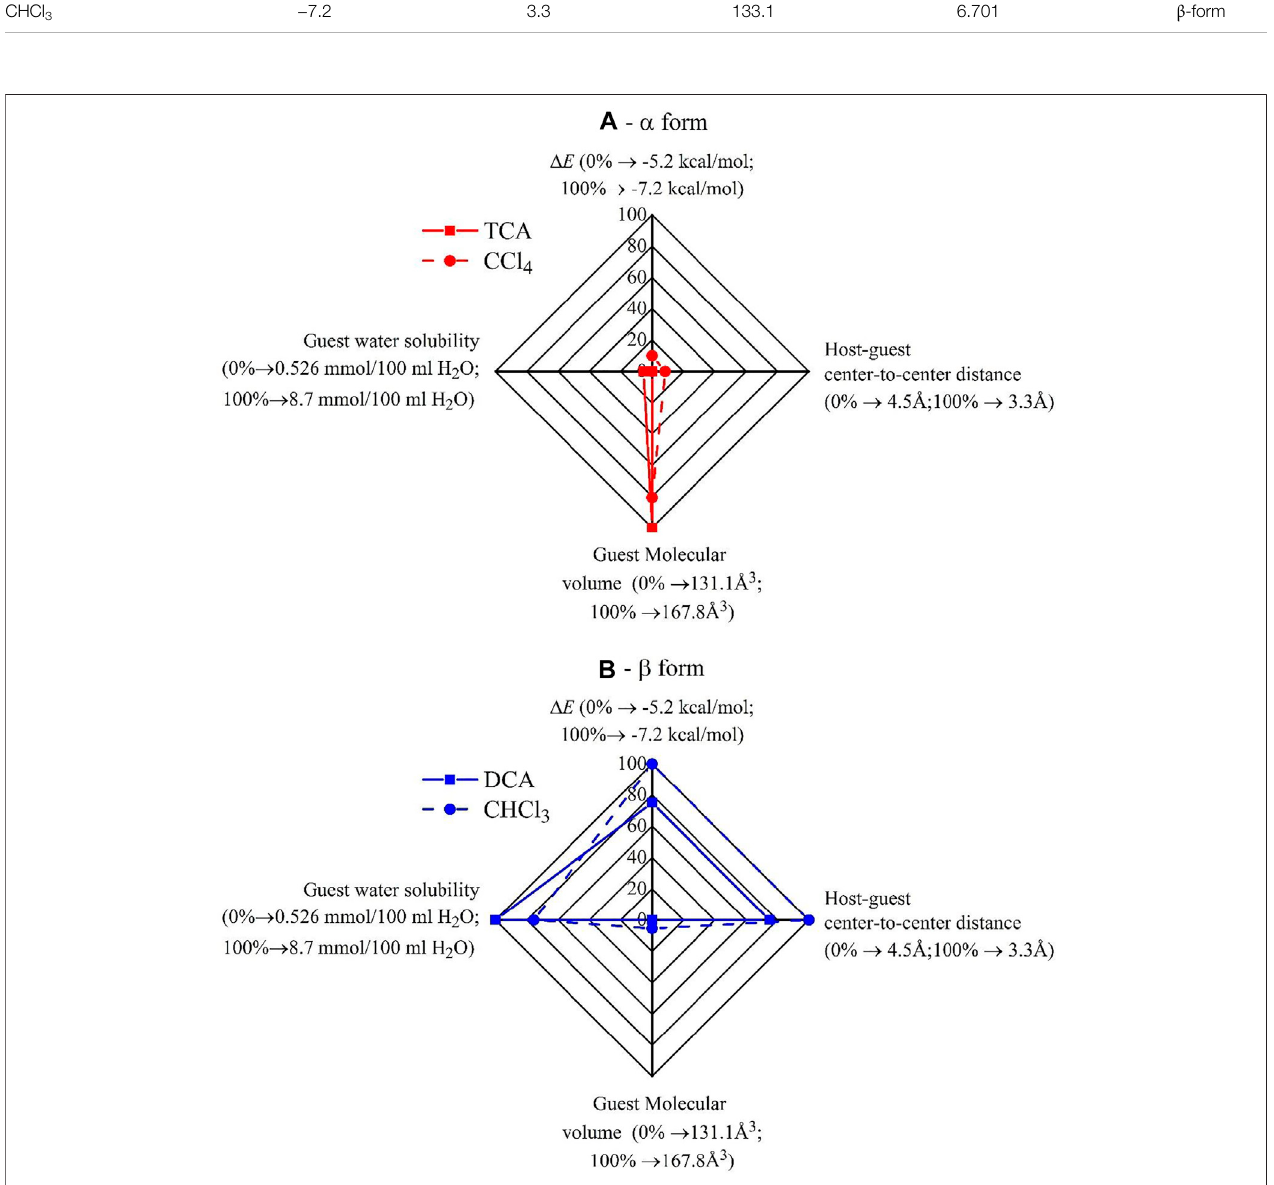
FIGURE 6| Kiviat diagrams illustrating the role ofthe leadingparameters controlling the guest-induced crystallization of PPO in CC and NC α - (A) and β -forms (B) . The lowest and the highest values ofthe parameters were scaled to 100 and 0%, respectively,for Δ E and d CM1-guest , and to 0 and 100%, respectively, for the molecular volume and water